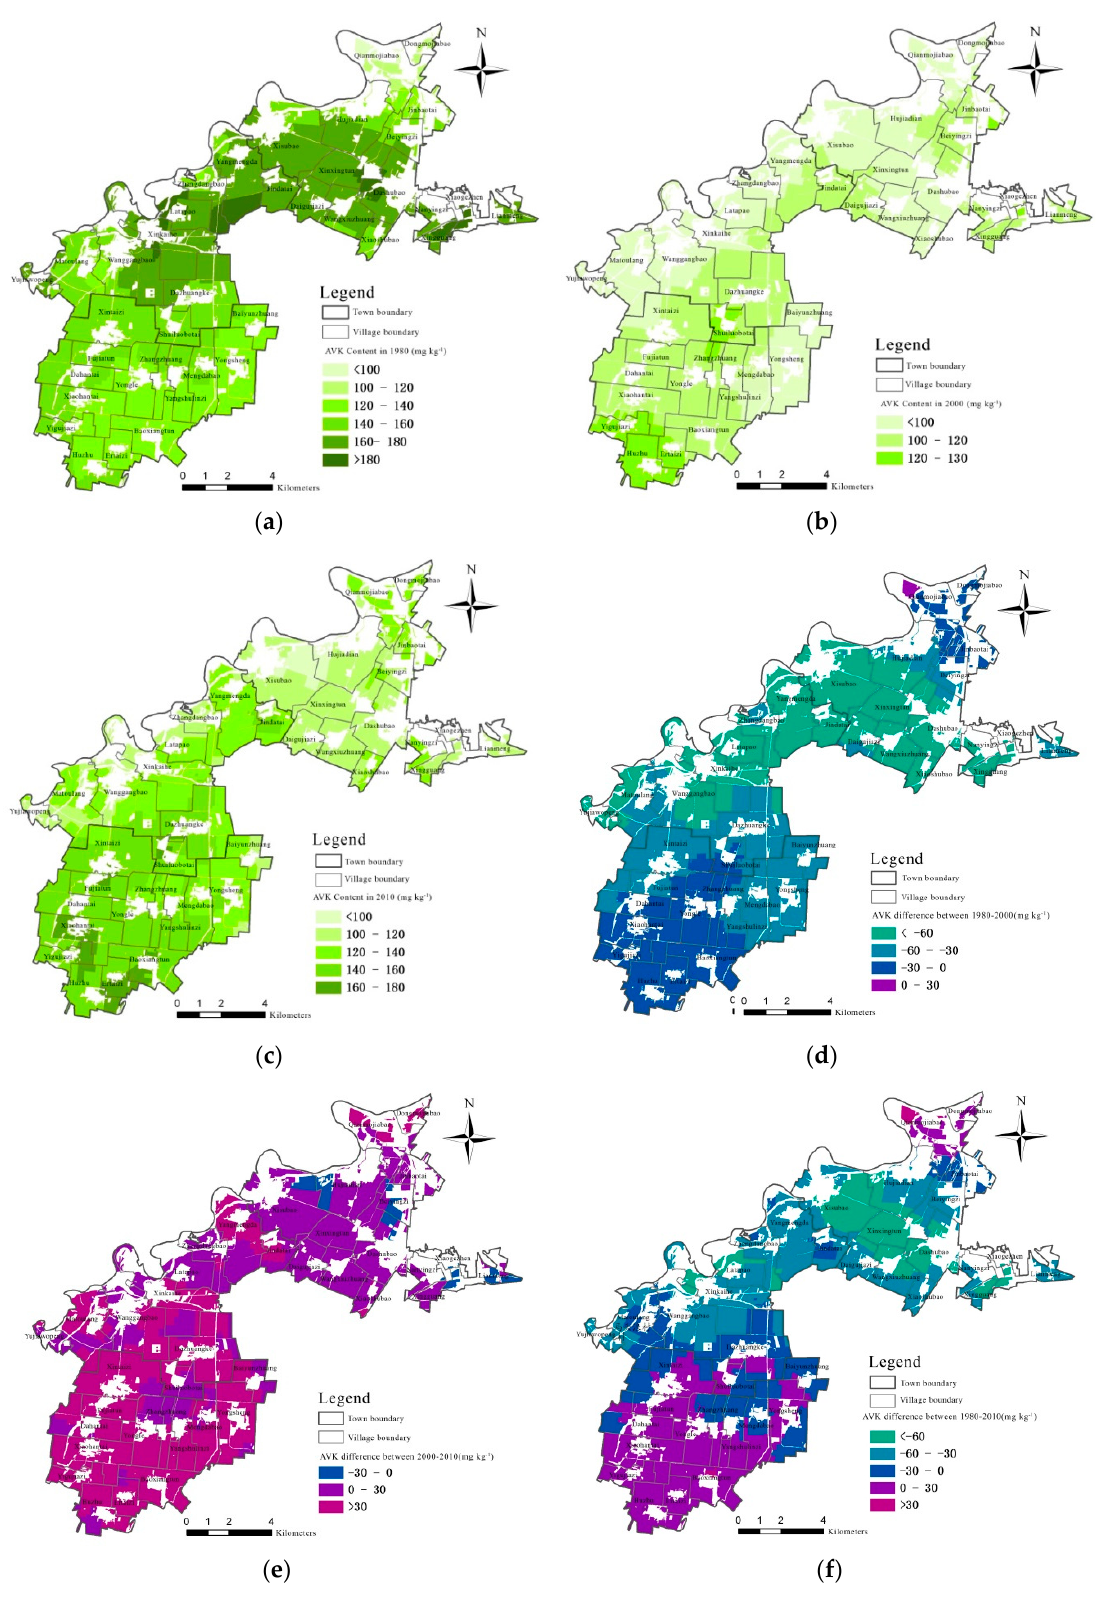
Figure 3. Spatial distribution of soil AVK content in the study area from 1980 to 2010. ( a ) Distribution